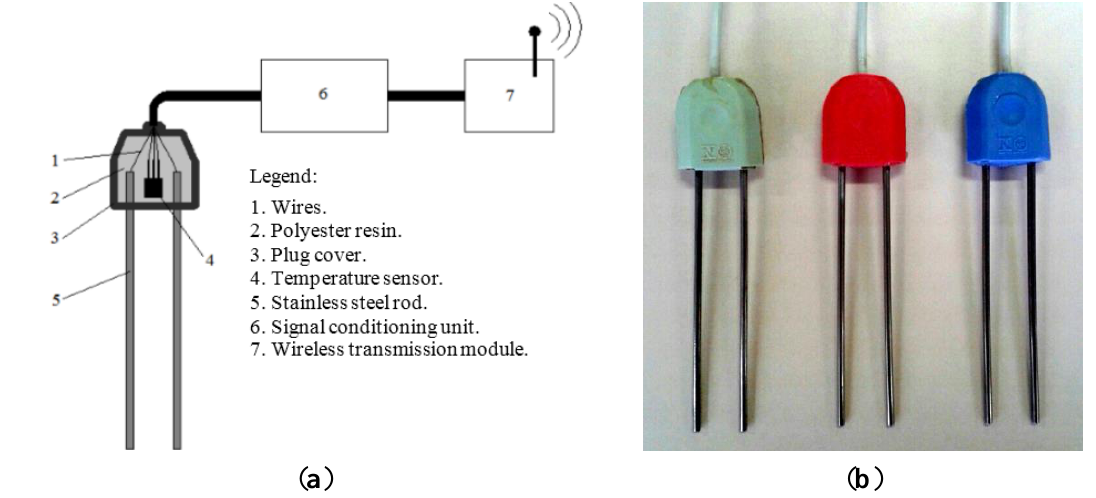
Figure 1. ( a ) Probe for measuring water content and apparent electrical conductivity of soil; ( b ) Probes for measuring temperature, electrical conductivity and relative dielectric